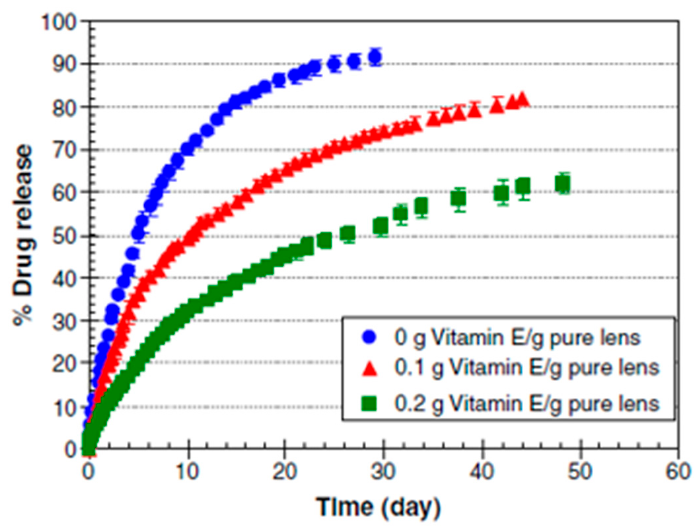
Figure 5. Effect of vitamin E on cumulative release of CsA from ACUVUE ® OASYS™ contact lenses. Adapted from reference [73]. Copyright 2011 Elsevier.